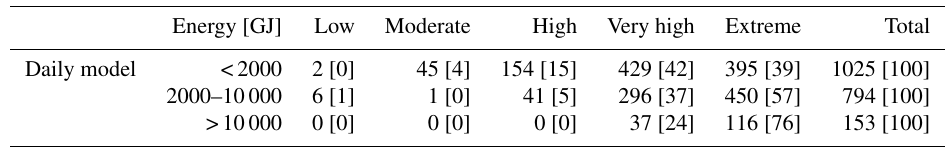
Table 2. As in Table 1 but for distributions obtained in the validation period (January–September 2017) of fire events among classes of fire danger as obtained from the daily